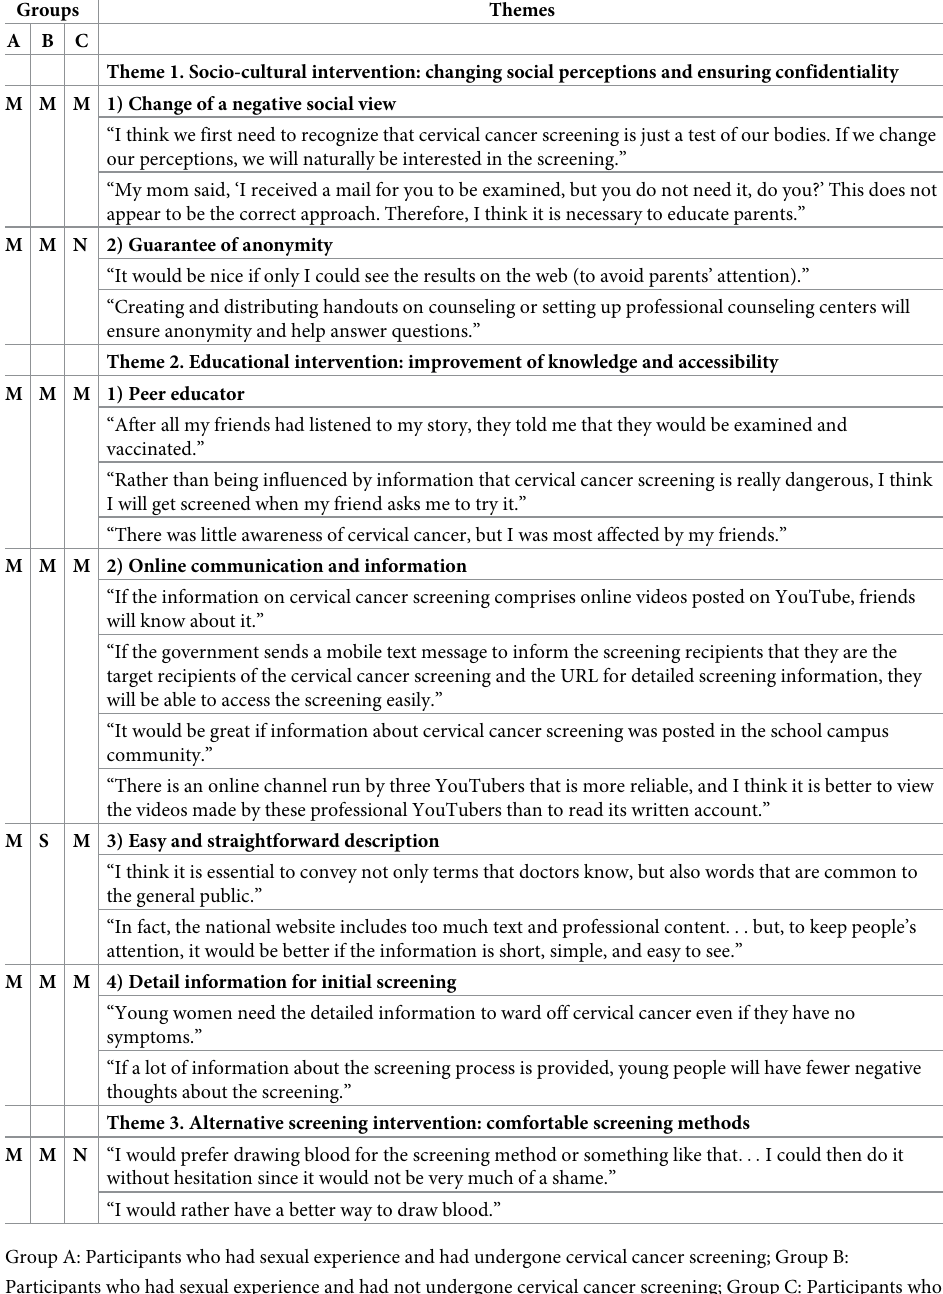
Table 3. Strategies for participation in cervical cancer screening (N =